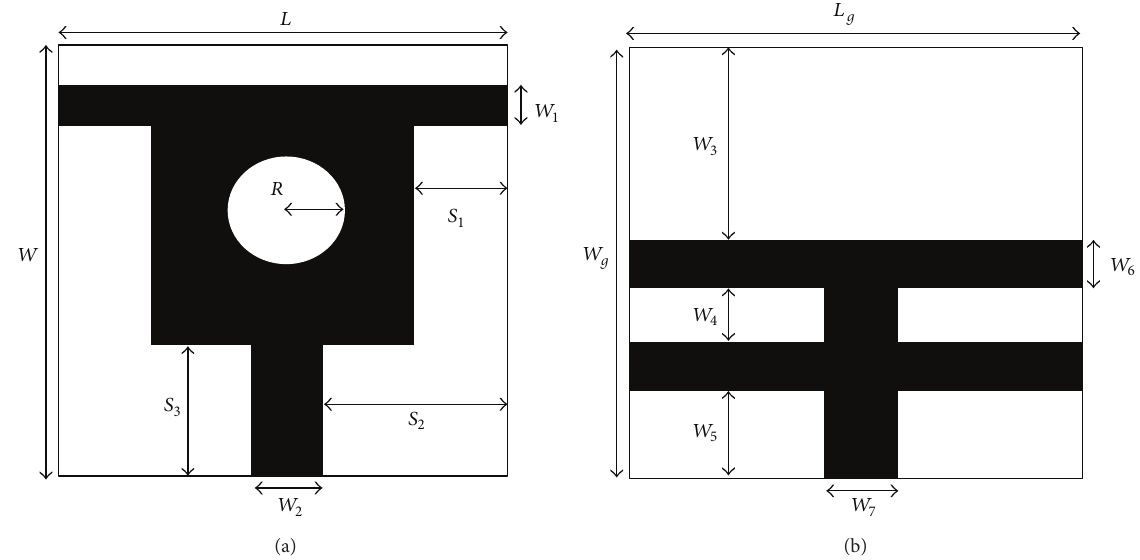
Figure 1: The proposed antenna (a) top view and (b) Bottom view.